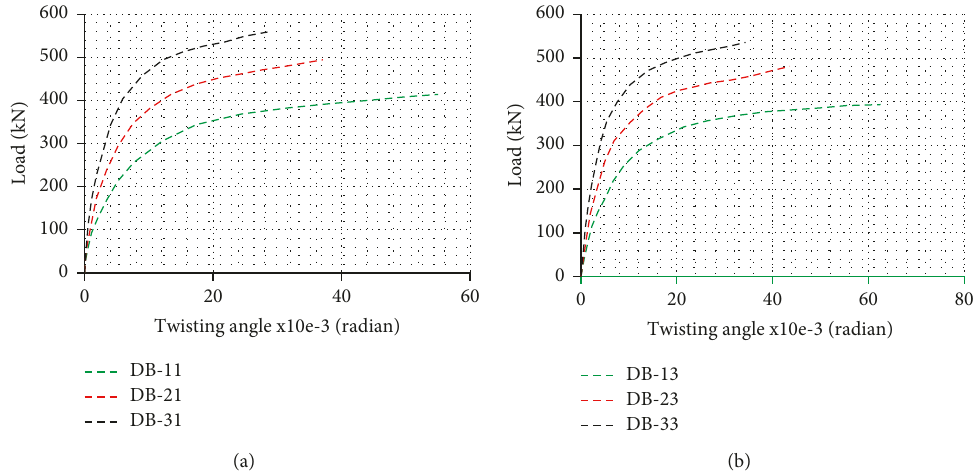
Figure 12: Load-rotation response curves with different L/D ratios of 3, 2.67, and 2.4. (a) Beam with L/R ratio equal to 1.05 and (b) beam with L/R ratio equal to 1.57.